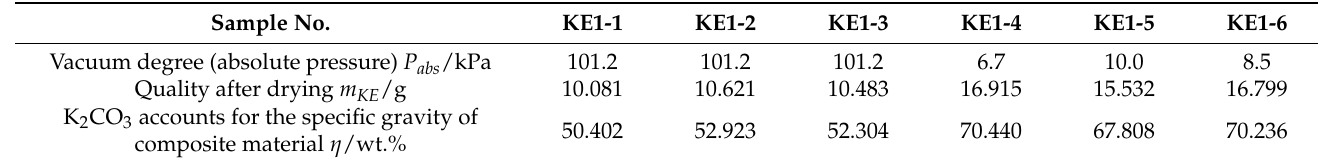
Table 2. KE1 series sample